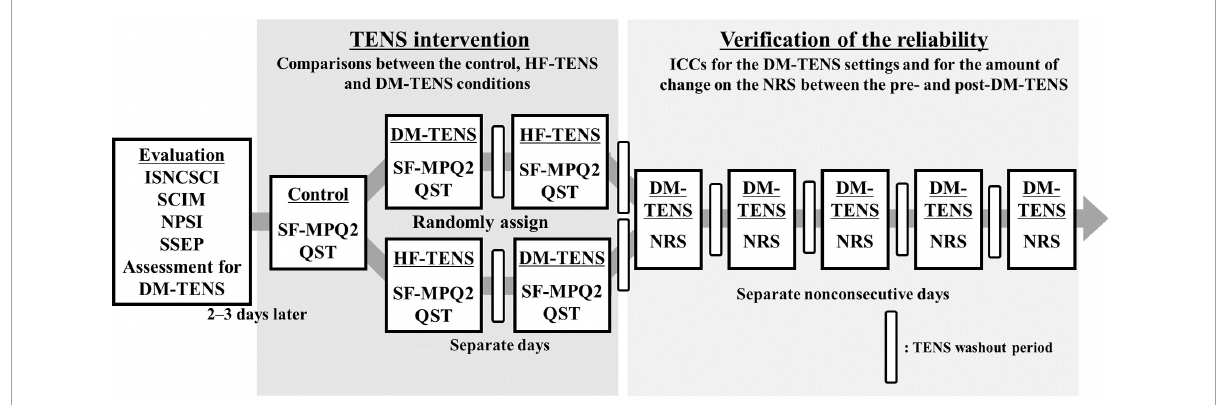
FIGURE1 Flow diagram of the experimental procedures. Assessments of the patients’ spinal cord injury symptoms and an assessment for the detection of the DM-TENS setting were conducted. Next, in the TENS interventions, DM-TENS and conventional HF-TENS were administered on separate days, randomly. The patients were each subjected to the DM-TENS settings five times on separate non-consecutive days to determine the reliability of the DM-TENS settings. ISNCSCI, the International Standards for the Neurological Classification of Spinal Cord Injury; NPSI, the self-administered Neuropathic Pain Symptom Inventory; NRS, the numeric rating scale ranging for the degree of the subjective dysesthesia; QST, quantitative sensory testing; SCIM, Spinal Cord Independence Measure; SF-MPQ2, Short-Form McGill Pain Questionnaire version-2; SSEP, short-latency somatosensory evoked